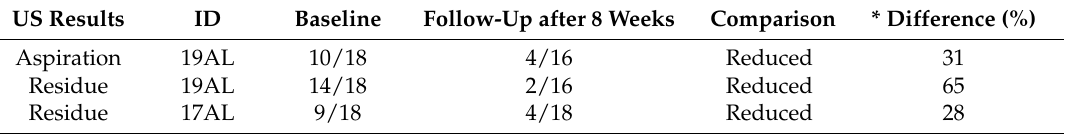
Table 3. Changes in the frequency of aspiration and residue in the intervention group.